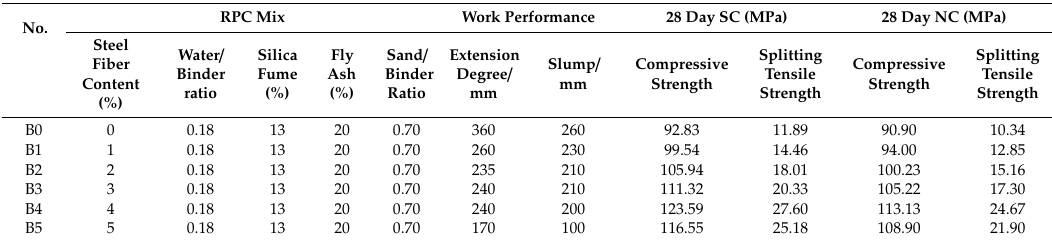
Table 12. Mechanical properties of steel fiber-reinforced RPC under standard and natural curing conditions.